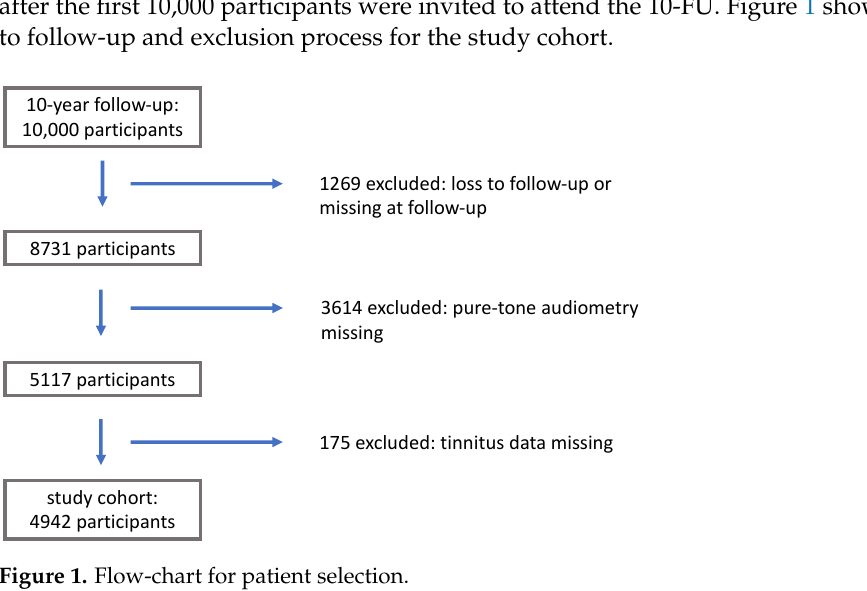
Figure 1. Flow-chart for patient selection.